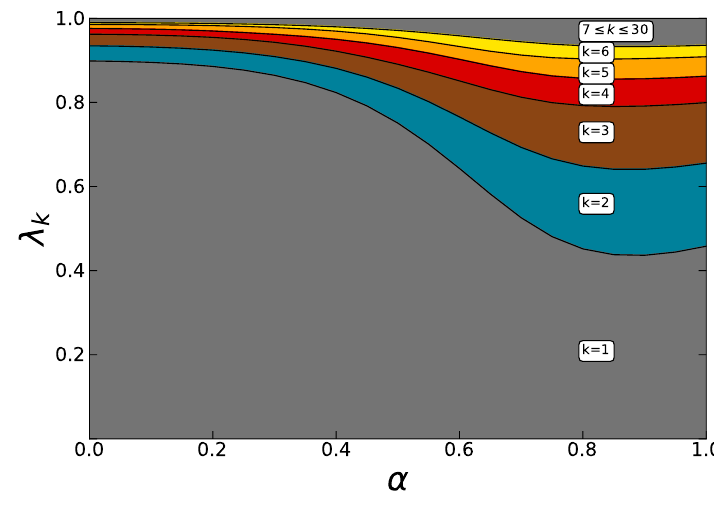
Figure 3. PCA eigenvalues as a function of the renewable mix α . The solar share increases towards α = 0, and the wind share increases towards α =